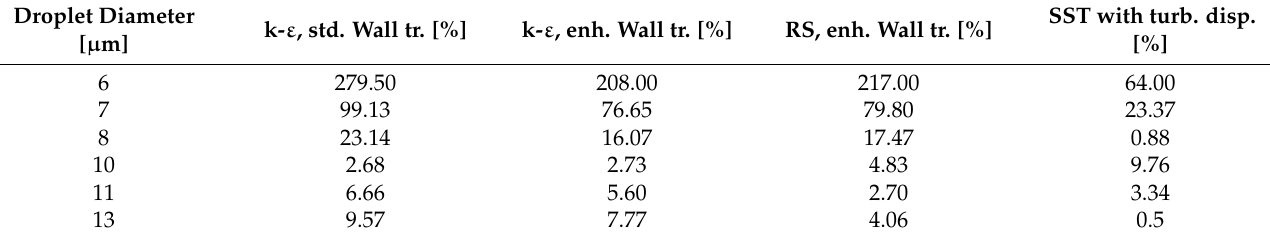
Table 5. Relative errors between calculated results and experimental data for geometry B_10_0 with inlet velocity 4 m s − 1 . Droplet Diameter